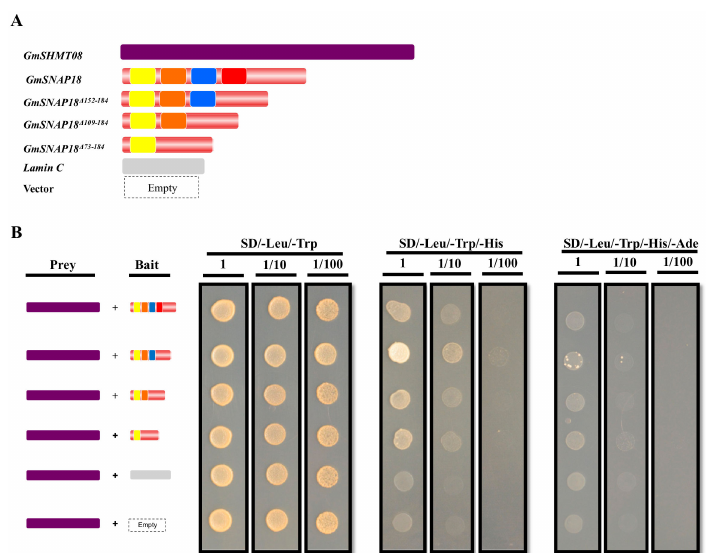
Figure 1. Impact of mutational analysis of the four TPR motifs GmSNAP18 interaction with GmSHMT08 in yeast. ( A ) Schematic structures of GmSHMT08 and GmSNAP18 constructs used in the yeast co-transformation assays. ( B ) Summary of yeast co-transformation assays. Yeast strain AH109 was co-transformed with GmSHMT08 prey vector together with bait constructs containing one ( GmSNAP18 ∆ 73-184 ), two ( GmSNAP18 ∆ 109-184 ), three ( GmSNAP18 ∆ 152-184 ), or four (full length) TPR domains of GmSNAP18. Yeast cells containing bait and prey plasmids were selected by plating the cells on the SD / -Leu / -Trp medium. GmSNAP18 / GmSHMT08 interaction were determined by di ff erential growth on the selective SD / Leu / -Trp / -His and SD / -Leu / -Trp / -His / -Ade media. Empty bait plasmid and bait plasmid containing the human Lamin C gene were used as negative controls. Yellow, orange, blue, and red boxes represent TPR1, TPR2, TPR3, and TPR4 Tetratricopeptide repeat motifs at GmSNAP18 predicted protein, respectively. 1, 1 / 10, and 1 / 100 represent serial dilutions of the co-transformed yeast cells. The experiment was repeated three times and similar results were